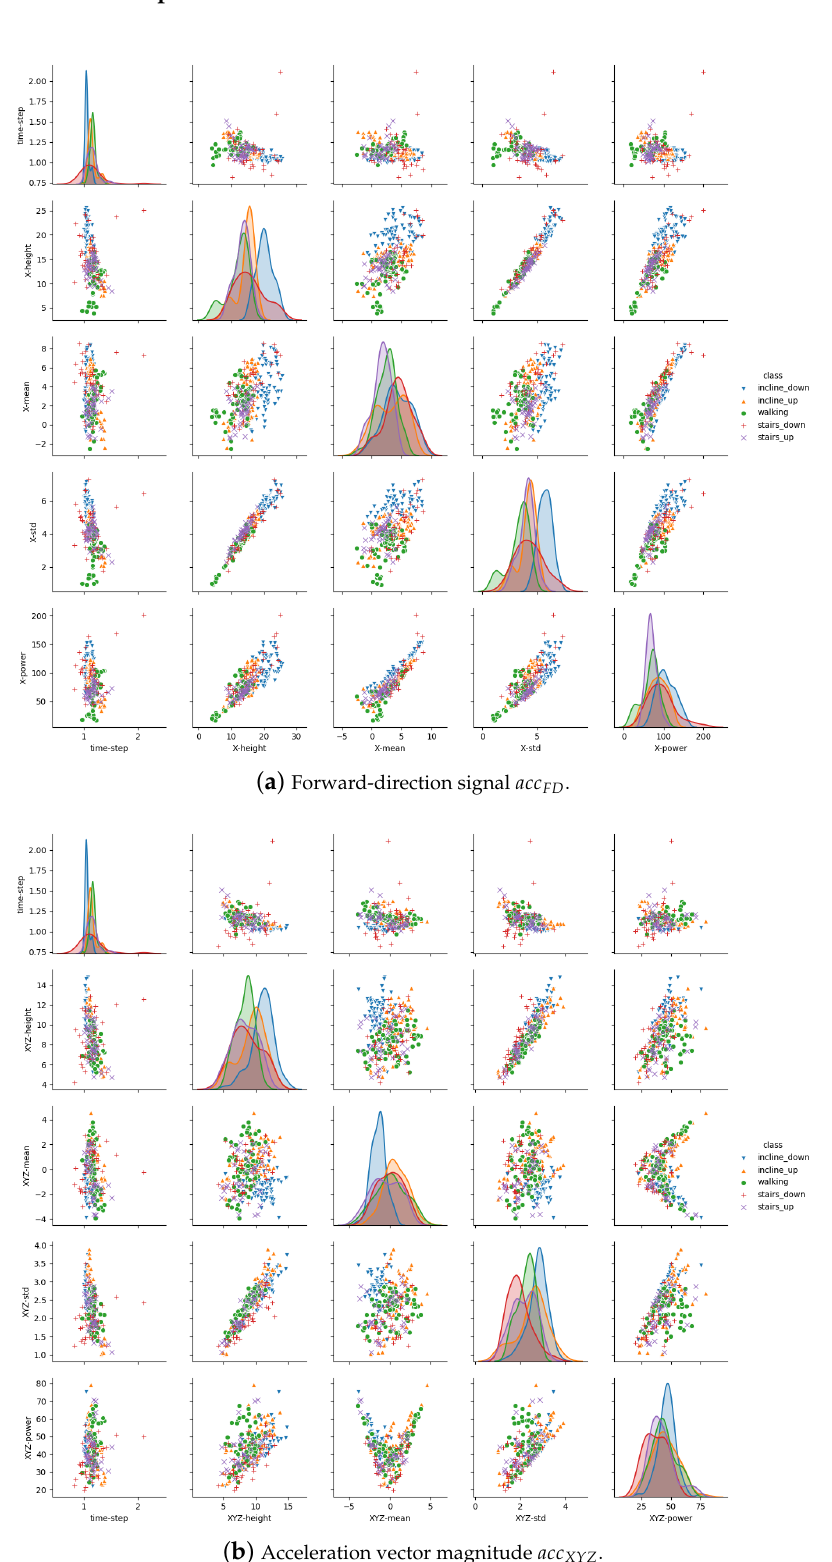
Figure A1. Visualization of feature space in forward-direction signal ( a ) and acceleration vector magnitude ( b ) from smartphone